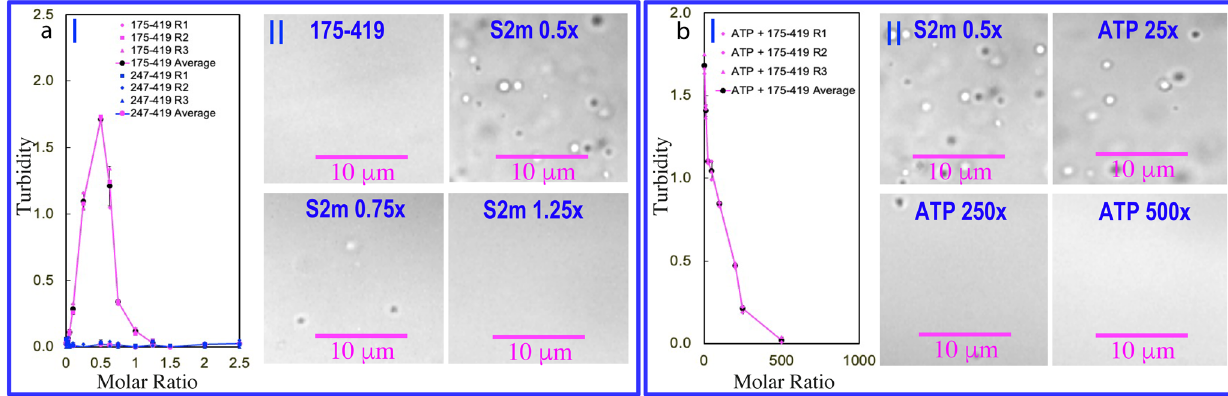
Fig. 7 S2m and ATP modulate LLPS of N (175-419). a Turbidity curves of the average values of three repeated measurements ( n = 3) with STD displayed as error bars of N (175-419) and N (247-419) in the presence of S2m at different ratios (I); and DIC images of N (175-419) in the presence of S2m at different ratios. b Turbidity curves of the average values of three repeated measurements ( n = 3) with STD displayed as error bars of N (175-419) in the presence of S2m at 1:0.5 with additional addition of ATP at different ratios (I); and DIC images of N (175-419) in the presence of S2m at 1:0.5 with additional addition of ATP at different ratios